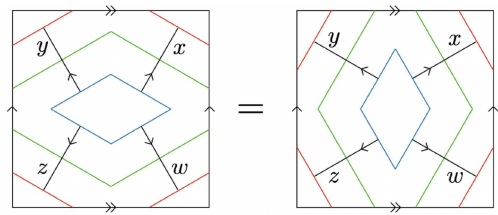
Figure 15 . The transition amplitude for a twice-punctured torus does not depend on a time function on it. The blue lines represent the initial time-slice and the red lines represent the final time-slice. A time-slice at an intermediate time, which consists of two disjoint circles, is represented by the green lines. Two different ways to split the initial circle into the intermediate circles give rise to the same transition amplitude. The auxiliary lines are omitted in the above